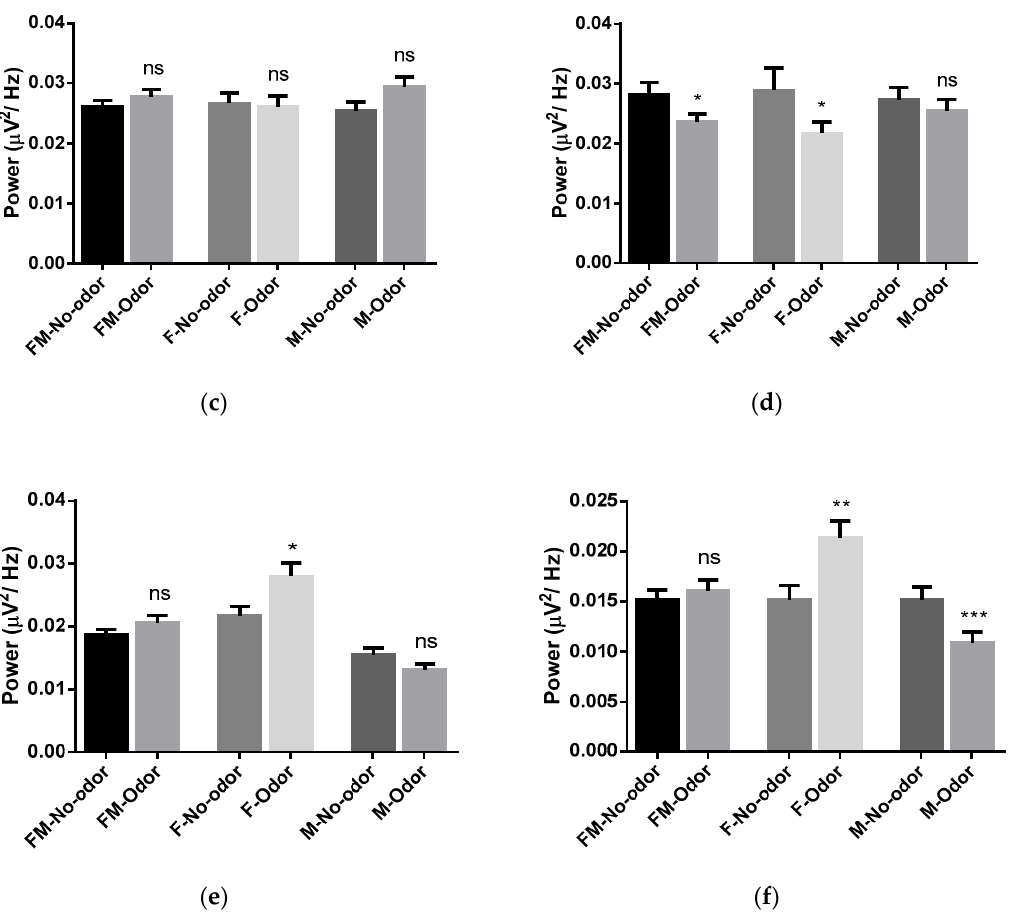
Figure 4. Brain area analysis of beta wave activities of frontal and centro-temporal regions. ( a , b ) Low beta wave activities at frontal and centro-temporal regions, respectively. ( c – d ) Mid beta wave activities at frontal and centro-temporal regions, respectively. ( e – f ) High beta wave activities at frontal and centro-temporal regions, respectively. F, M, and FM represent female subjects, male subjects, and female and male subjects, respectively. ns, *, **, and *** represent no statistical differences, p < 0.05, p < 0.01, and p < 0.001, respectively.